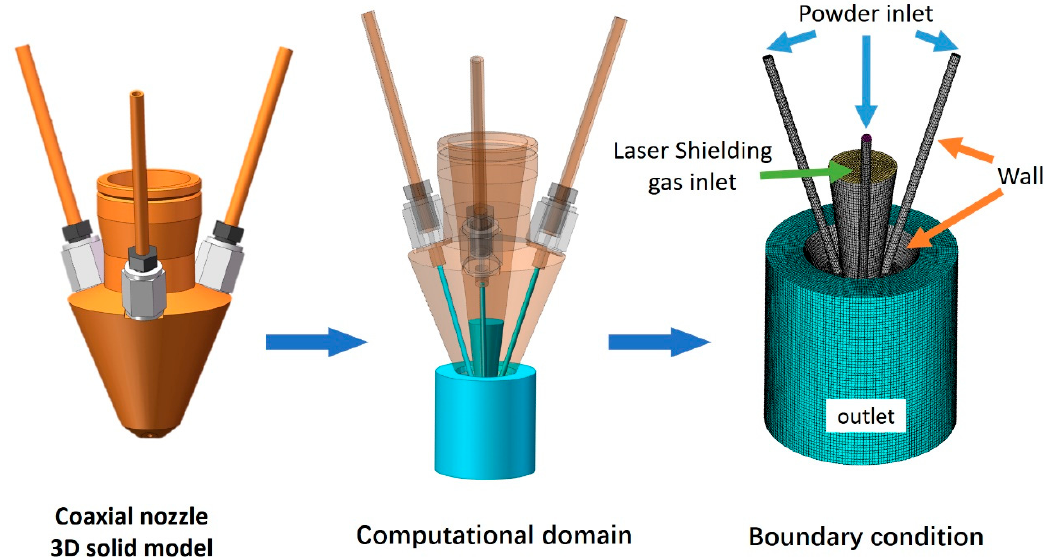
Figure 1. The establishment of computational domain and its boundary conditions.